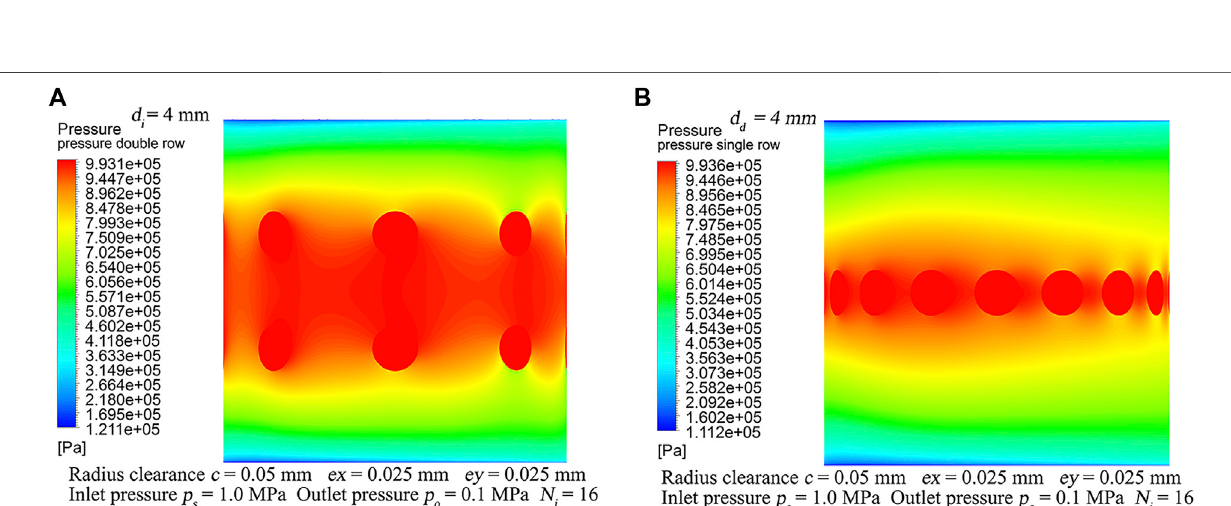
Frontiers in Energy Research |